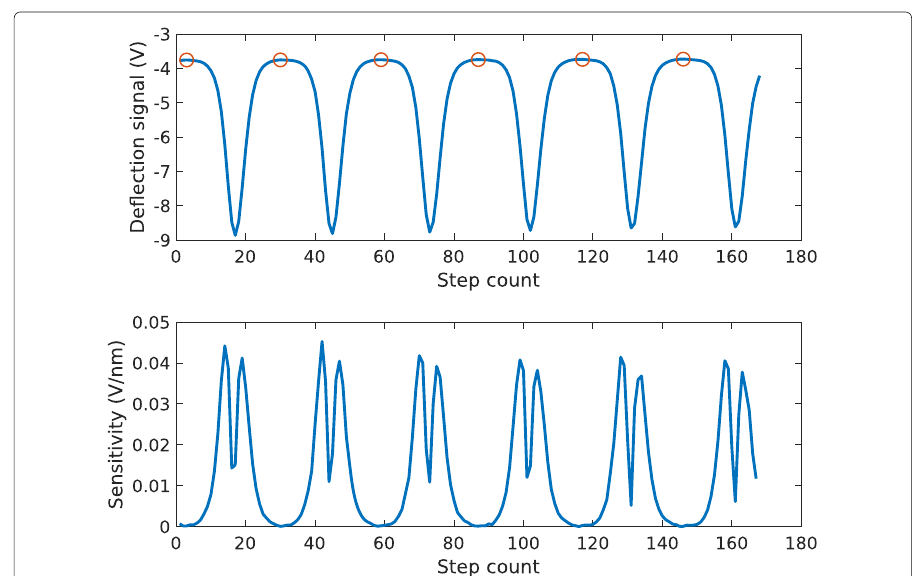
Fig. 6 Top shows the photodiode signal as a function of the number of fiber walker steps as it is retracted from the cantilever. Peaks are indicated via circles, which are then used to determine the number of steps between adjacent fringes. Bottom shows sensitivity S which is calculated by taking the derivative of the photodiode signal and dividing by the average step size between fringes √ √ Hz. The best detection detection noise at 77 K is ≈ 50 fm / Hz and at 4 K is ≈ 15 fm /